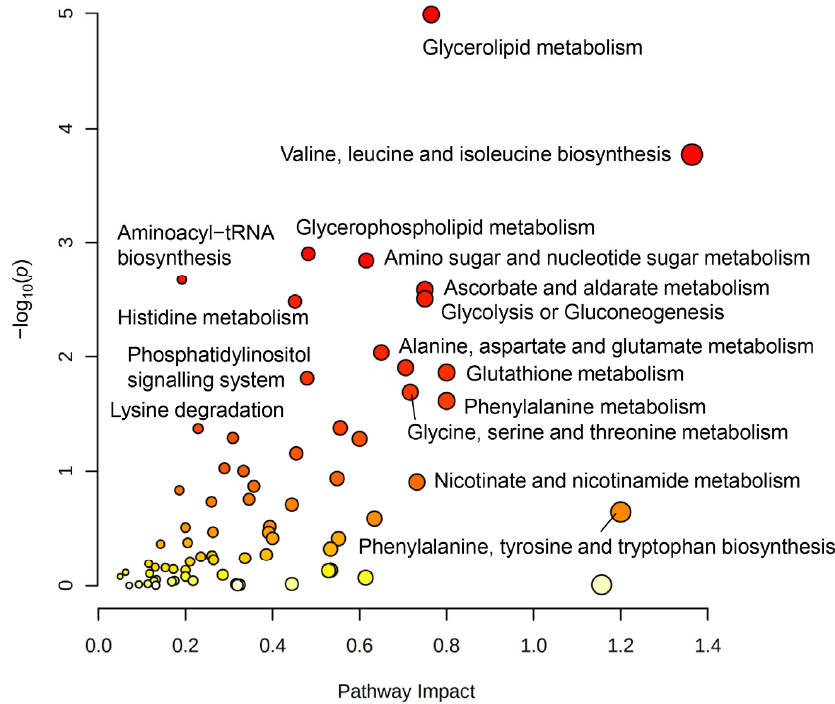
Figure 6. Joint pathway analysis of 1 H-NMR spectroscopy-based metabolomics and RNA-seq gene fold change data. Pathway analysis indicates the most significantly changed metabolic pathways (the node color scheme is based on p -values from yellow dots = low significance to red dots = high significance and the node radius is determined based on the pathway impact value). Glycerolipid metabolism, branched-chain amino acid (BCAA) metabolism of valine, leucine, and isoleucine biosynthesis, glycerophospholipid metabolism, amino sugar and nucleotide sugar metabolism, ascorbate metabolism, glycolysis or gluconeogenesis, and alanine, aspartate, and glutamate metabolism, were most affected based on Kyoto Encyclopedia of Genes and Genomes (KEGG) pathway database. For joint-pathway analysis, data from metabolomics ( n = 4) and RNA-seq ( n = 4) were